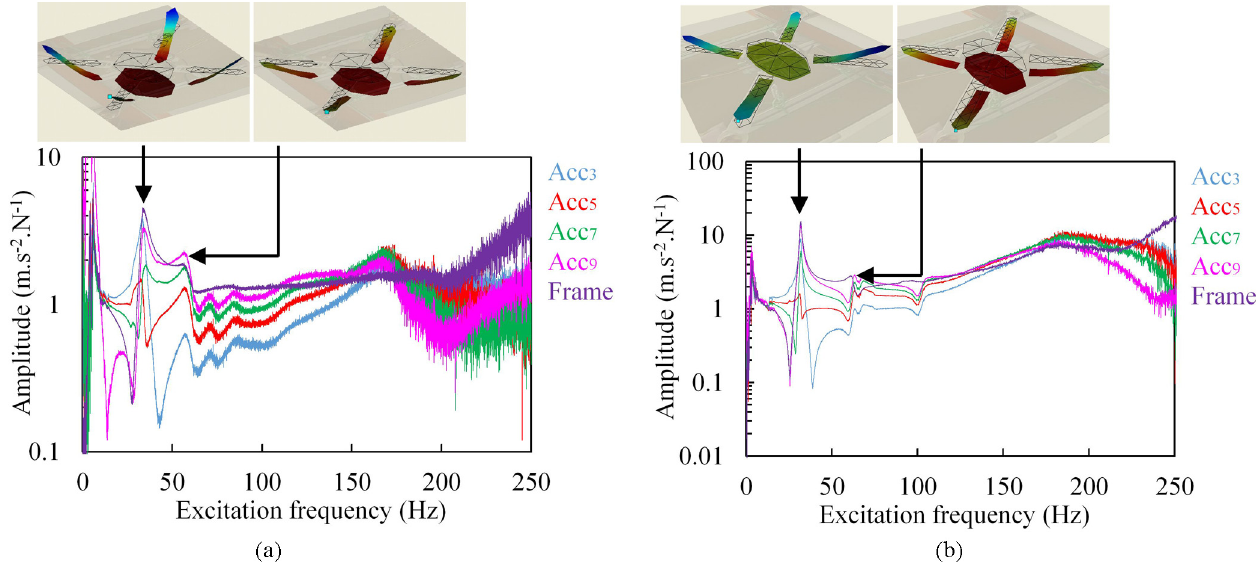
Fig. 7. FRF computed by injecting a white noise at the center of the (a) initial drone and the (b) revised drone, both without